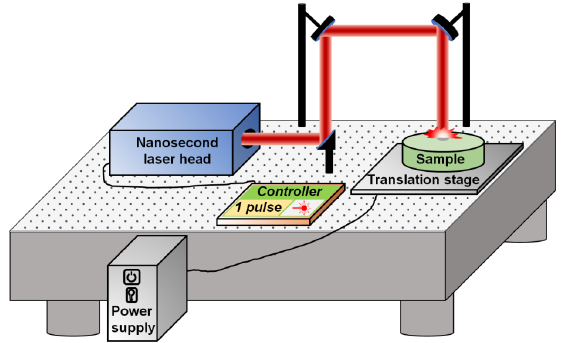
Figure 1. Experimental setup of single-shot nanosecond laser processing on metal surfaces.